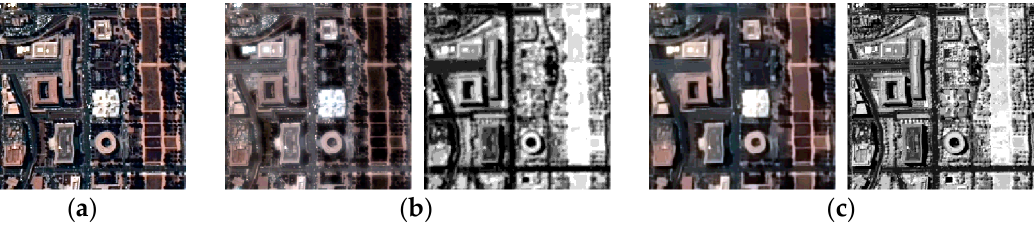
Figure 3. Spatial details extracted by average filtering and intrinsic image decomposition methods. ( a ) HS image; ( b ) Average filtering method ( left : Spectral component of HS image; right : Spatial component of HS image); ( c ) Intrinsic image decomposition method ( left : Reflectance component of HS image; right : Illumination component of HS image).